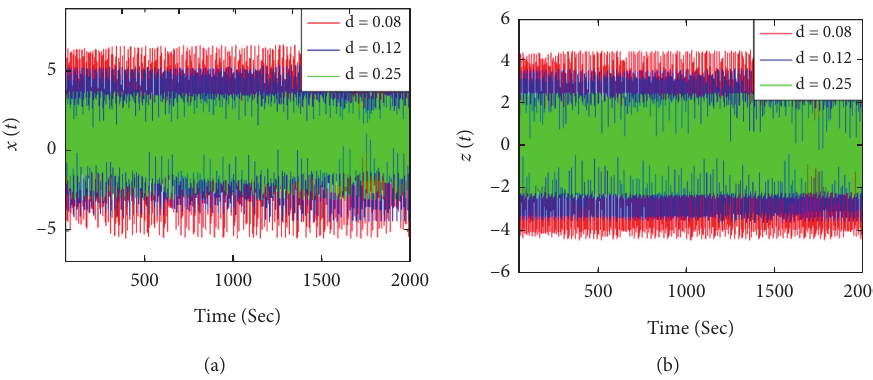
Figure 16: Signals x ( t ) and z ( t ) with different amplitudes controlled by